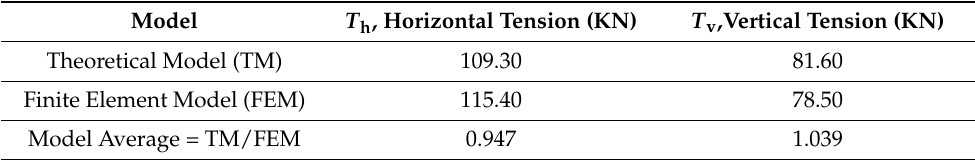
Table 12. Validation by comparing the hose values for maximum tension .